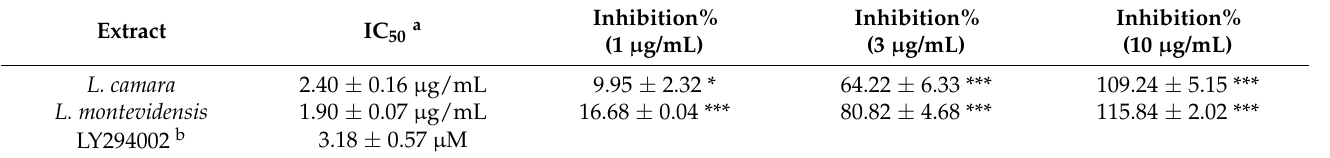
Table 4. Effects of Lantana extracts on elastase release in fMLF/CB-induced human neutrophils. Extract